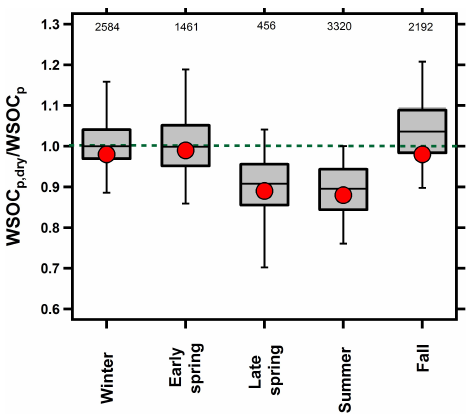
Figure 1. Box plot of the overall seasonal WSOC p,dry / WSOC p ratios. For each bin, mean (red marker), median (horizontal black line), 25th and 75th percentiles (lower and upper box values), and 5th and 95th percentiles (vertical lines) are shown. The dotted green line at unity is shown for visual reference. Numbers at the top rep- resent the number of paired WSOC p,dry / WSOC p measurements within each